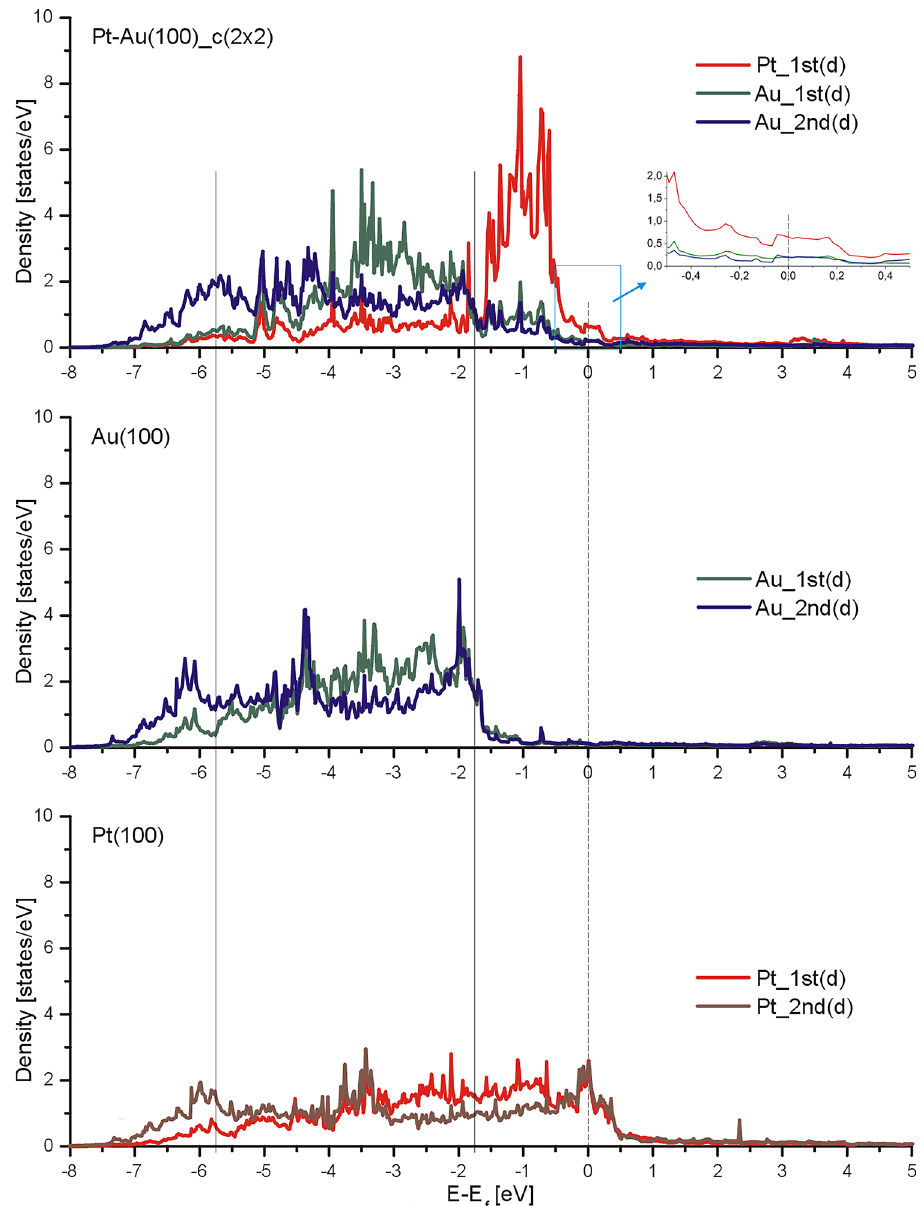
Figure 5. Local density of d -states obtained for Pt(100)-(1 × 1) (bottom image), Au(100)-(1 × 1) (middle image) and Pt/Au(100)-c(2 × 2) (upper image).